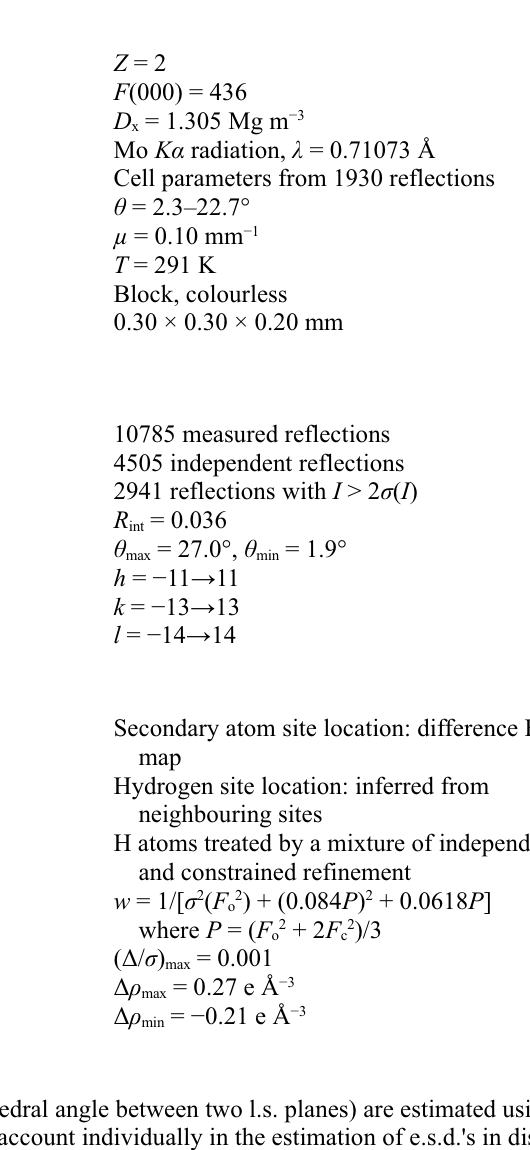
Figure 2 A view of the packing and hydrogen bonding interactions of (I). Ethyl 3-(4-fluorophenyl)-6-methyl-4-oxo- 2-(1-cyclohexylamino)-3,4-dihydrofuro[2,3- d